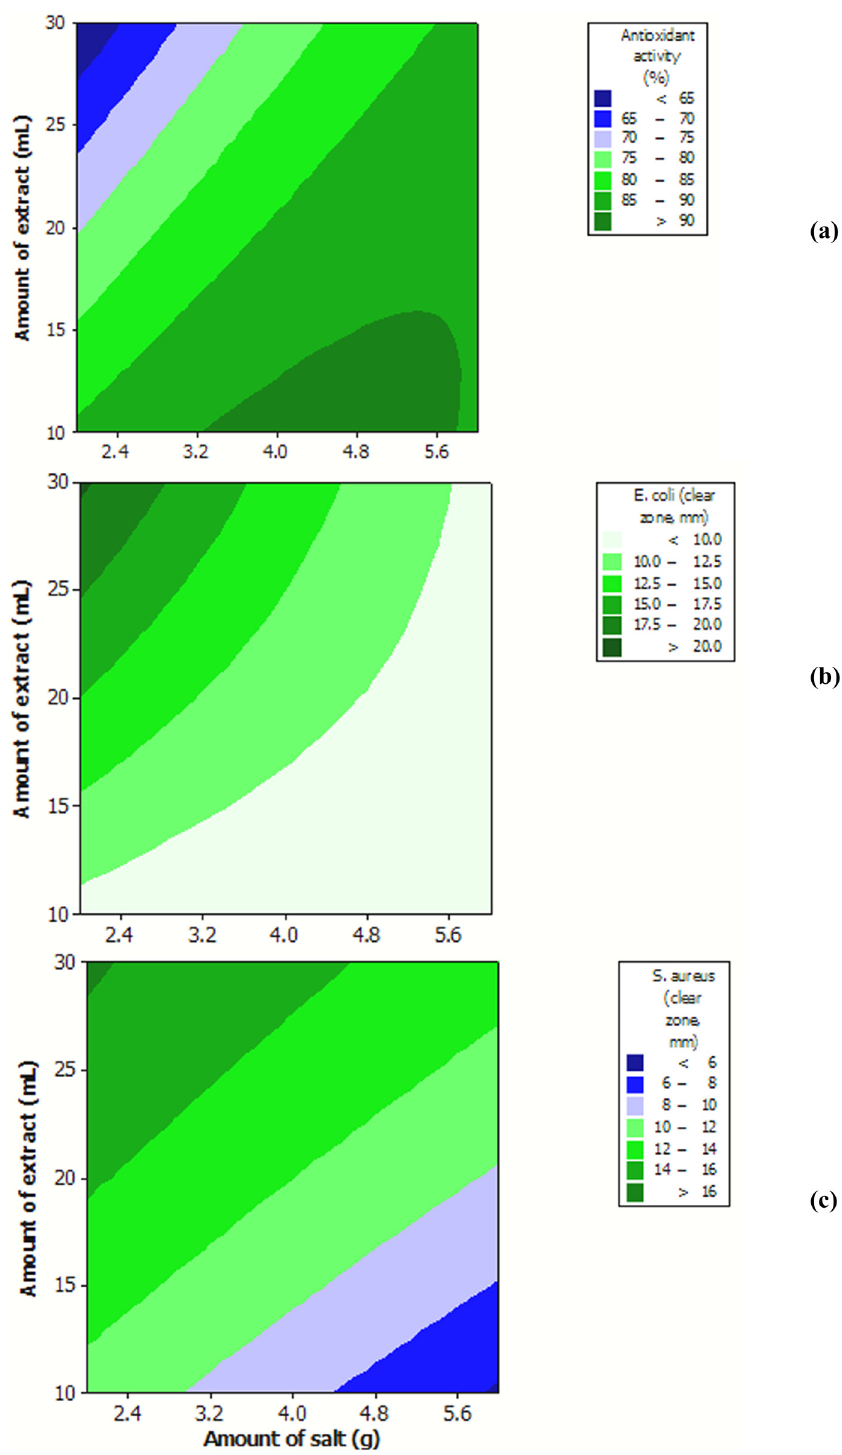
Figure 3: Contour plots for antioxidant activity ( a ) , antibacterial activities against E. coli ( b ) and S. aureus ( c ) of the synthesized ZnO NPs, as function of amounts of zinc salt ( g ) and clove extract ( mL )